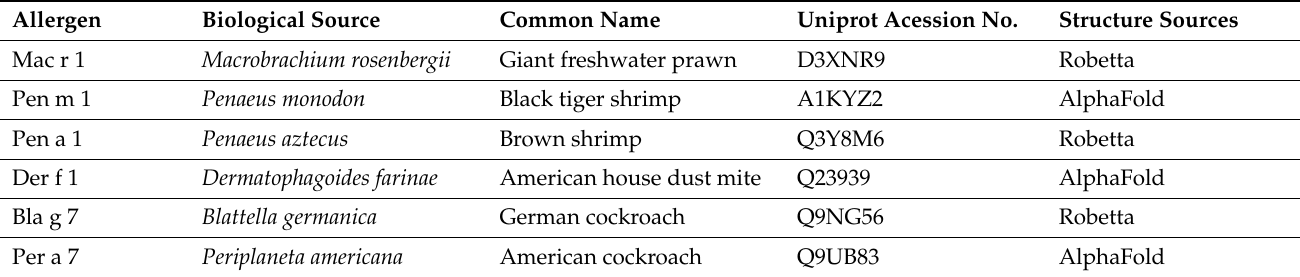
Table 1. Tropomyosin from different sources used in this study.